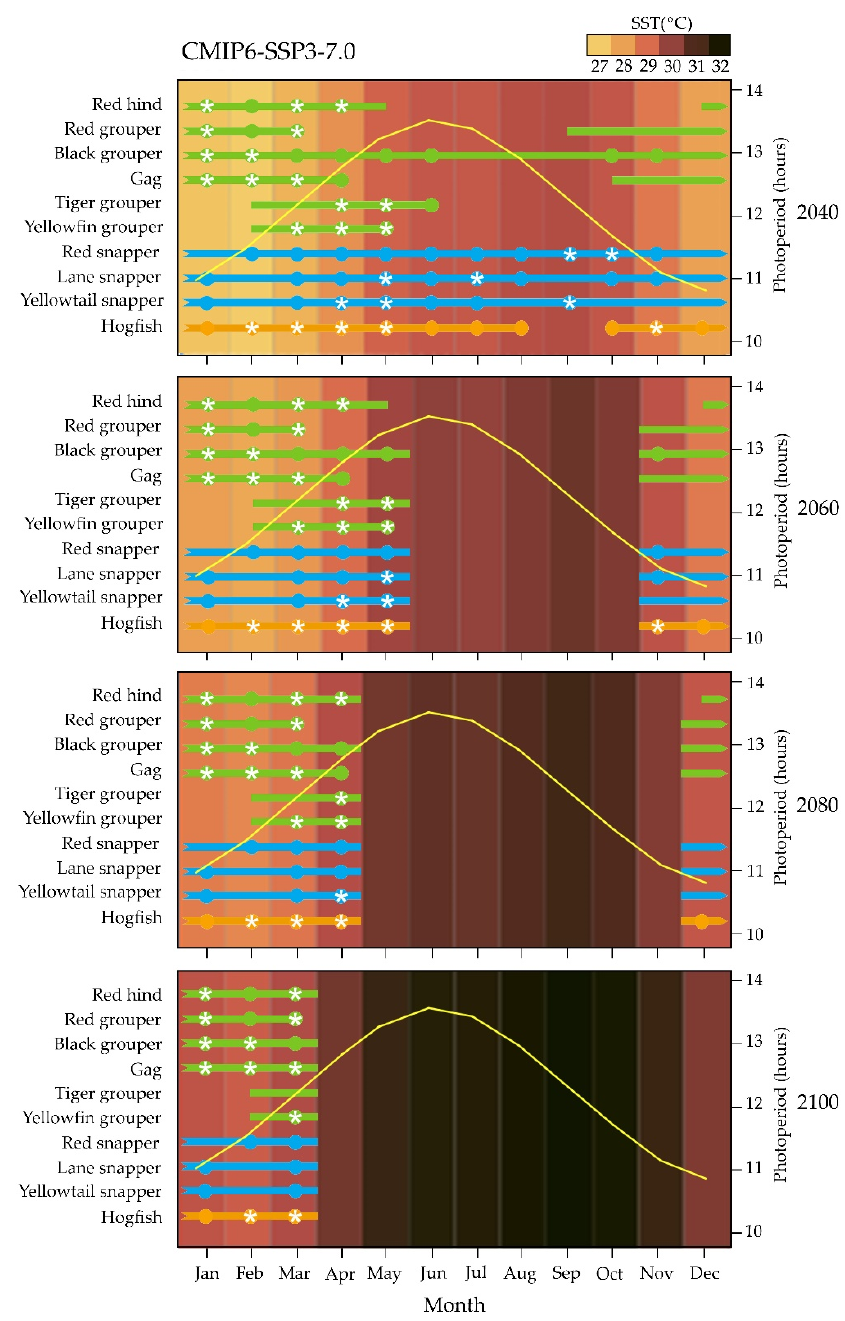
Figure 3. Hypothetical effect of climate change on reproductive cycle of studied grouper (green bars), snapper (blue bars), and wrasse (orange bars) species from the Campeche Bank, in relation to 2040, 2060, 2080, and 2100 monthly changes in mean sea surface water temperature (SST) predicted by the CMIP6 SSP3-7.0 scenario of the Intergovernmental Panel on Climate change [46–48]. For each species, solid bars represent reproductive season reported as the months that include spawning capable females; solid circles represent spawning season reported as the months that include actively spawning females, and white stars represent peak spawning reported as the months that include more than 50% of females in actively spawning sub phase (for reproductive phase terminology see [49]). Yellow curve indicates monthly photoperiod length (Time and Date AS 1995–2022. Available online: http://www.timeanddate.com/sun/mexico/merida, accessed on 1 March